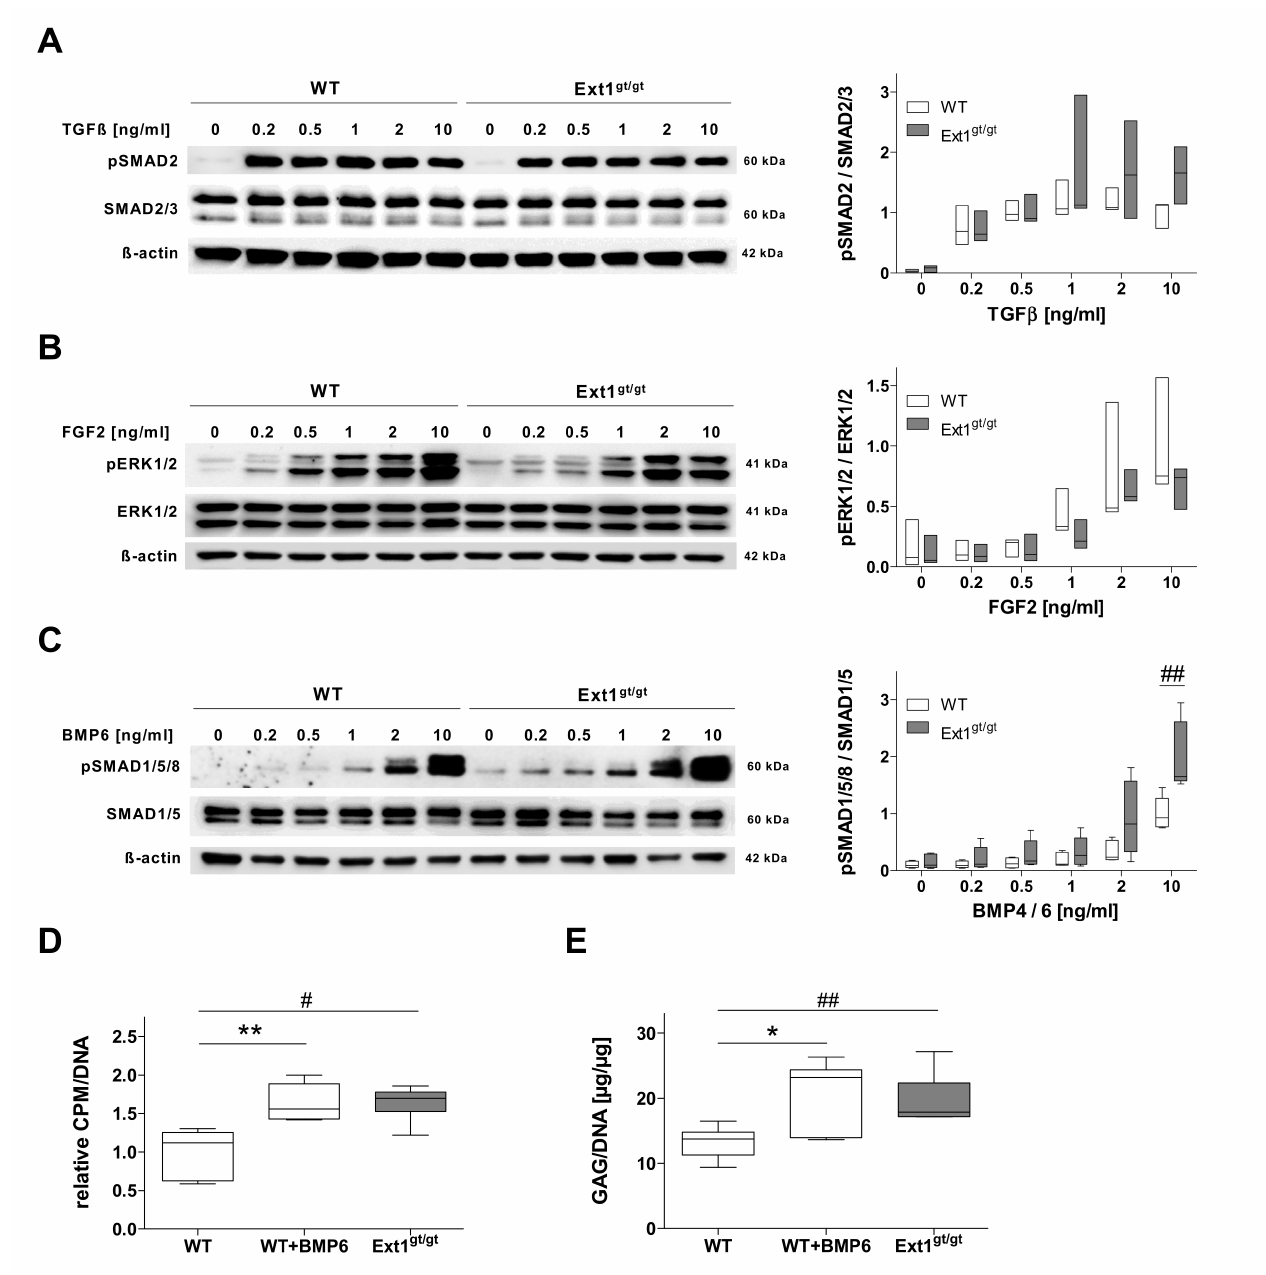
Figure 2. Influence of Ext1 -hypomorphism on growth factor signaling and GAG-production of engineered cartilage. ( A – C ) Ext1 gt/gt and WT chondrocytes were treated in fetal calf serum (FCS)-free monolayer culture with increasing concentrations of indicated growth factors for 3 h. Receptor activation was investigated by Western blot analysis of pSMAD2 /SMAD2/3 (TGF β , n = 3, 3 donors), pERK1/2 /ERK1/2 (FGF2, n = 3, 3 donors), and pSMAD1/5/8 /SMAD1/5 (BMP4/6, n = 5, 3 donors) levels with β -actin used as a loading control. Phosphorylated forms are considered biologically active. Representative blots are shown. Independent blots were standardized by setting the densitometric intensity of WT cells treated with 10 ng/mL growth factor to 1. ( D , E ) Engineered WT cartilage was cultured for 7 days under chondrogenic conditions with or without supplementation of 10 ng/mL BMP6 during the last 96 h ( n = 6, 3 donors). ( D ) GAG de-novo synthesis was determined by 35 S-sulfate incorporation over the last 24 h of differentiation culture. Values were normalized to DNA-content and the values of WT controls were set to 1. ( E ) GAG-content of engineered WT cartilage measured by DMMB assay and normalized to DNA-content. Box plots were generated as described in Figure 1. vs. Ext1 gt/gt (#)/untreated (*): Mann–Whitney U test #/* p < 0.05, ##/** p <